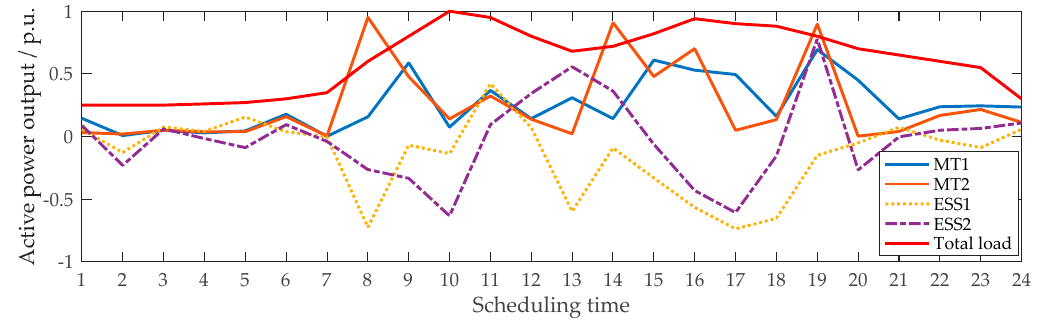
Figure 10. Daily scheduling of active power output of MTs and ESSs.